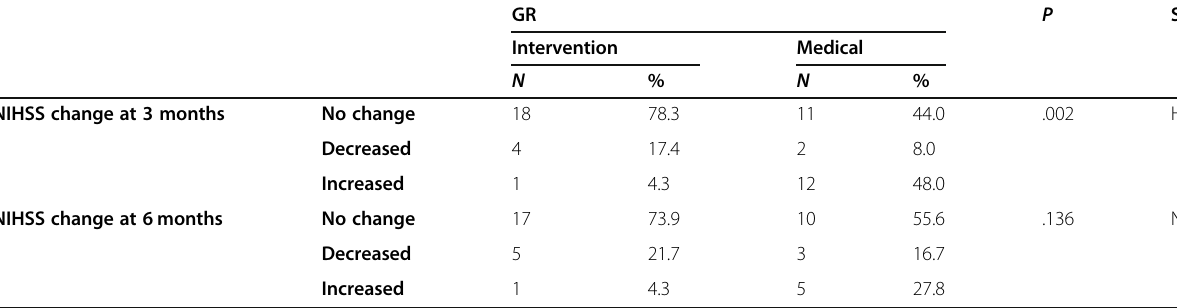
Table 3 NIHSS at baseline, 3 and 6 months of both groups GR Intervention group